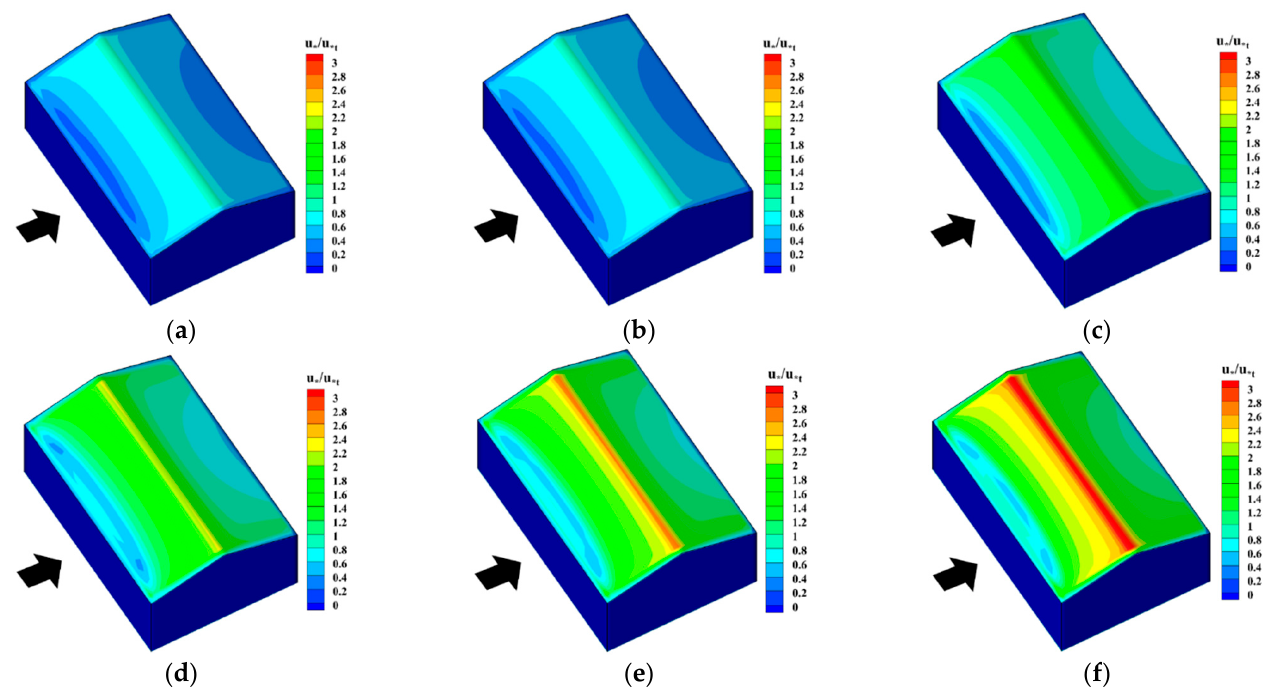
u u : ( a ) U H = 2 m/s; ( b ) U H = 3 m/s; ( c ) U H = 4 m/s; ( d ) U H * *t